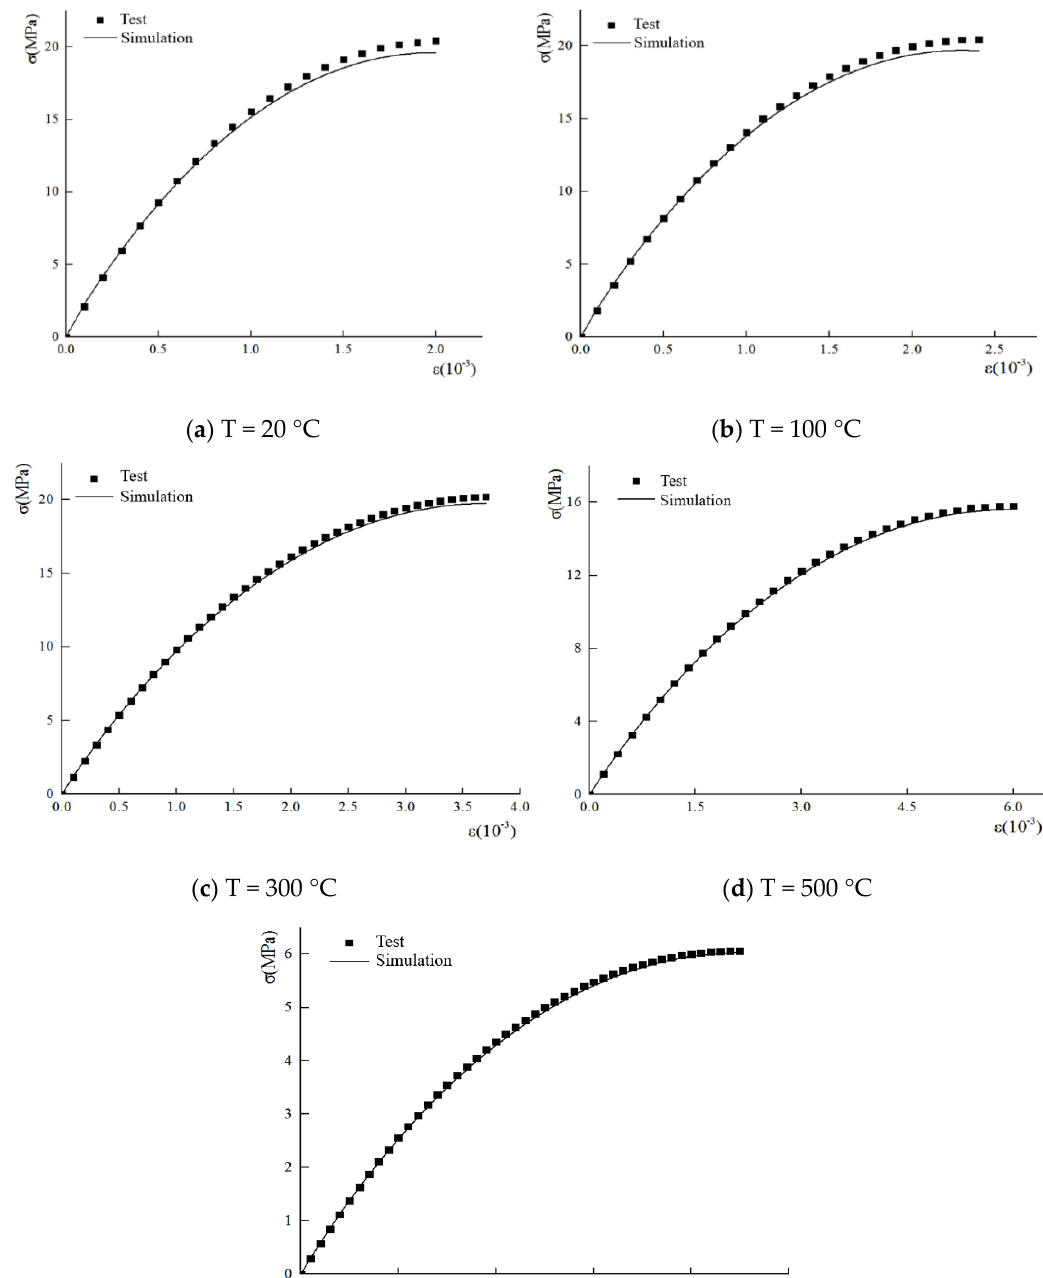
Figure 3. Comparison of simulation results and test results for C20 concrete.